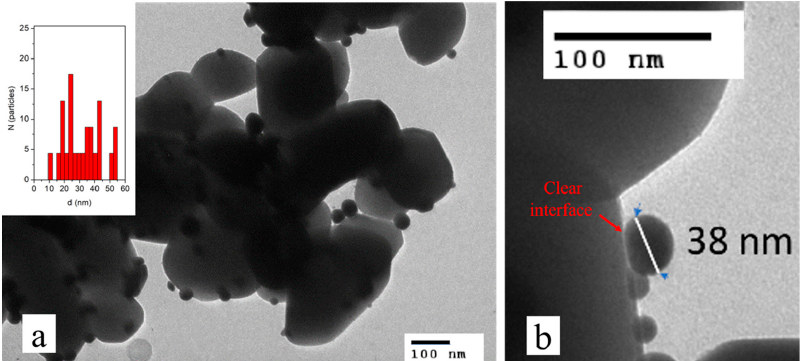
Figure 6. TEM image ( a ) of non-treated Au / TiO 2 nanocomposites produced by the plasma–liquid interaction method with a precursor concentration of 0.06 mM, the inset shows the particle size distribution histogram of gold nanoparticles. Magnification of TEM image ( b ) elucidating the sharp boundary between TiO 2 surface and gold nanoparticle.